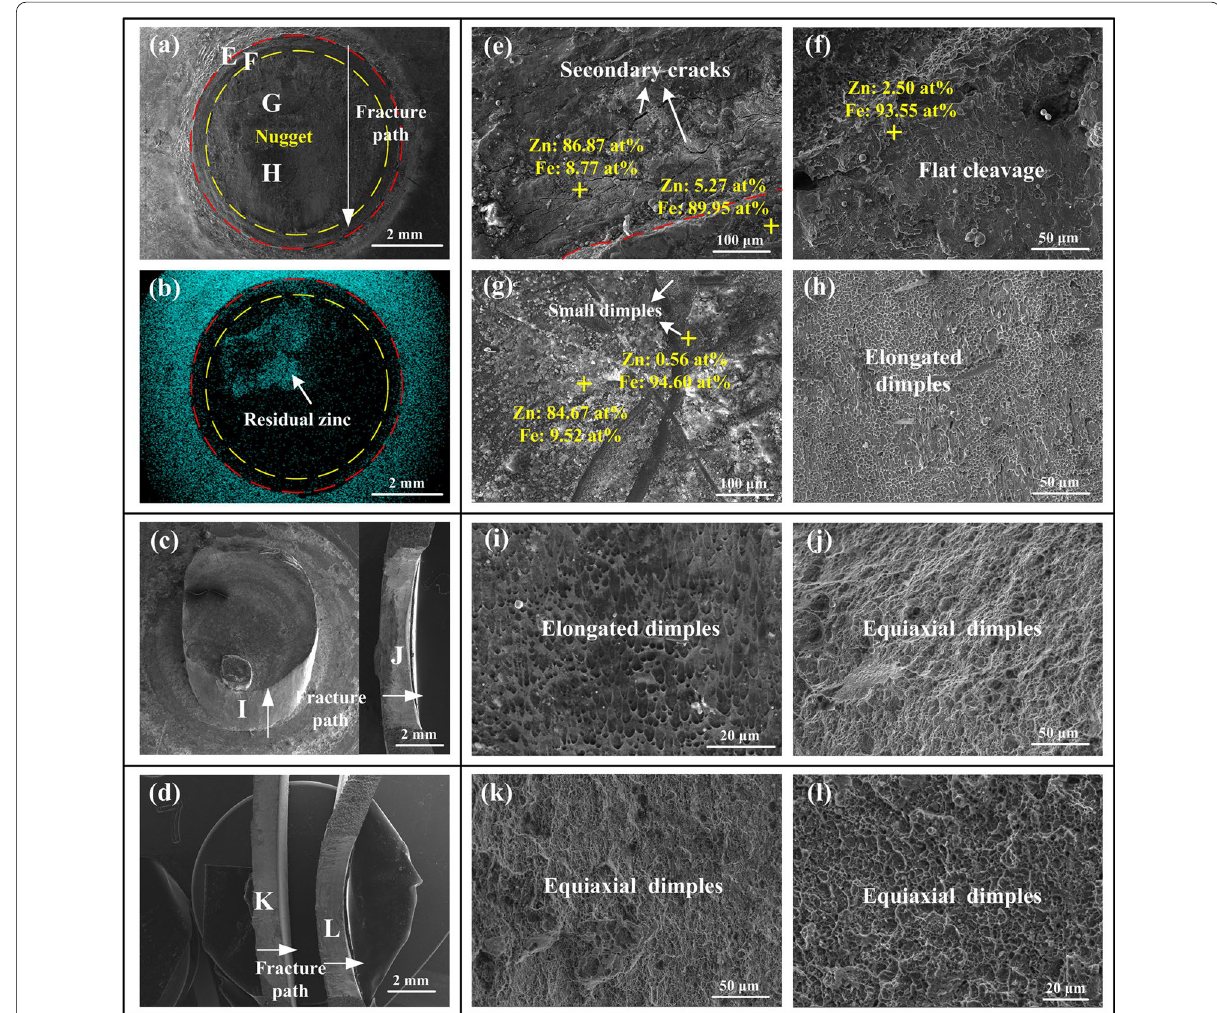
Figure 11 SEM images of fracture surface of ( a ) IF mode, ( b ) EDS zinc distribution at the surface of the IF sample, ( c ) PF mode, ( d ) TF mode and ( e ‒ l ) magnifications of position E ‒